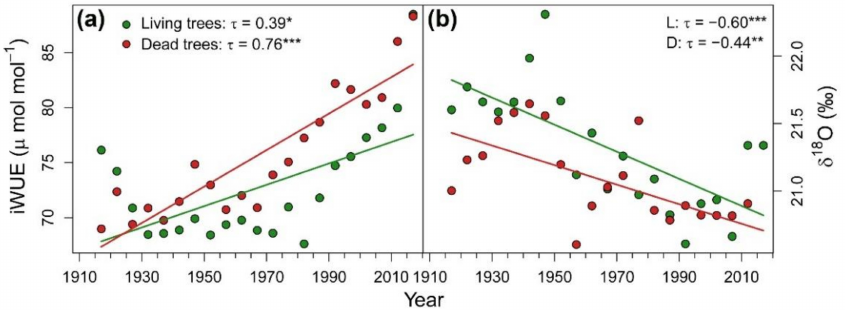
Figure 2. ( a ) Intrinsic water-use efficiency (iWUE) and ( b ) oxygen isotopic ratios ( δ 18 O) in tree rings of living trees (L; green symbols and lines) and dead trees (D; red symbols and lines) of Nothofagus dombeyi along the 1910–2018 period. Symbols represent values of five consecutive rings pooled at vigor class level and lines indicate significant trends based on the Kendall τ statistic. Kendall τ statistic and associated p -value (* p < 0.05; ** p < 0.01; *** p < 0.001) is indicated in each graph for both vigor